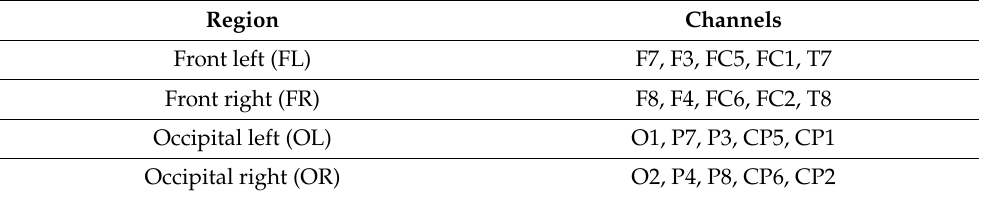
Table 2. Channels in brain